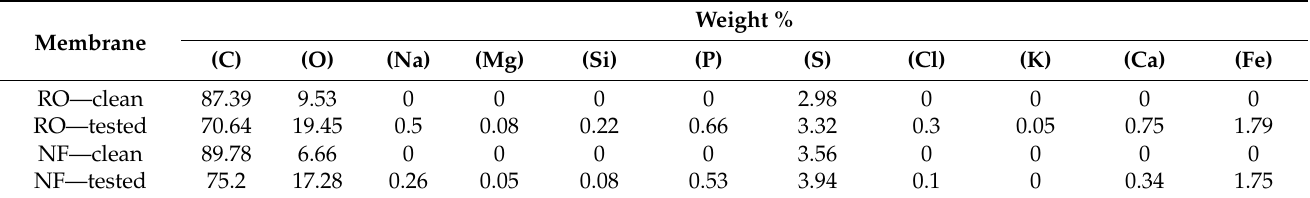
Figure 4. SEM images of ( a ) a clean RO membrane, ( b ) a tested RO membrane at a feed pressure of 12 bar, ( c ) a tested RO membrane at a feed pressure of 16 bar, ( d ) a tested RO membrane at a feed pressure of 20 bar, ( e ) a clean NF membrane, ( f ) a tested NF membrane at a feed pressure of 12 bar, ( g ) a tested NF membrane at a feed pressure of 16 bar, and ( h ) a tested NF membrane at a feed pressure of 20 bar. Table 3. Analysis of elements wt % on the surface of a clean and tested RO and NF membranes.